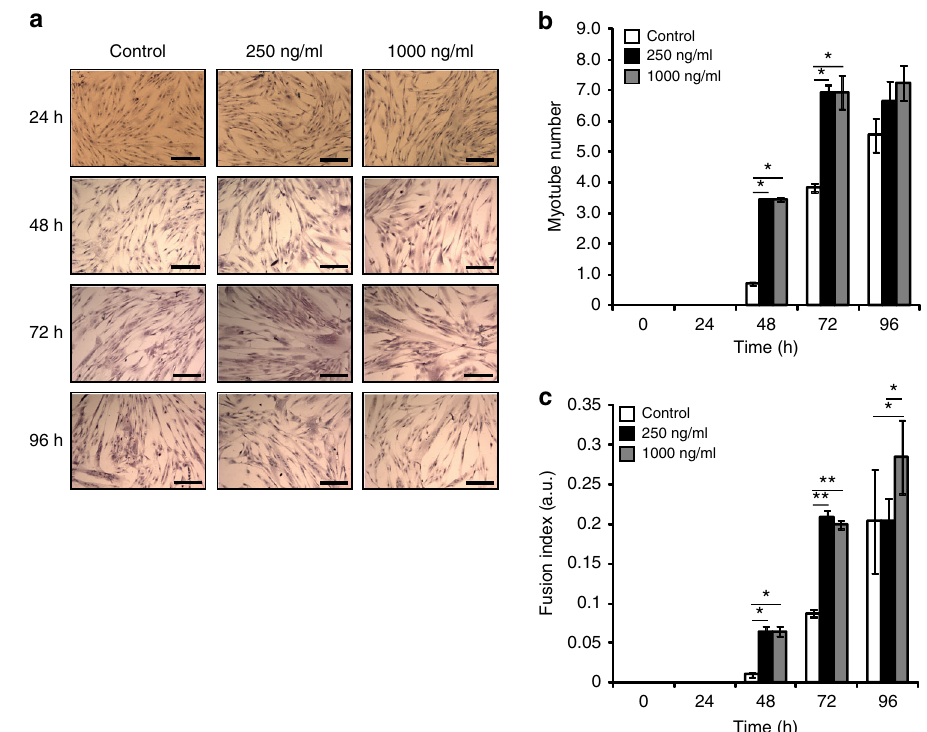
Fig. 3 Irisin enhances myogenesis in primary human myoblast cultures. a Representative images of H&E-stained 36C15Q primary myoblasts at 24, 48, 72, and 96 h of differentiation in the presence of DB (control) or irisin (250 and 1000 ng/ml). b Graph showing quanti fi cation of myotube number at 0, 24, 48, 72, and 96 h of differentiation in the presence of DB (control) or irisin (250 and 1000 ng/ml). c Graph showing quanti fi cation of fusion index at 0, 24, 48, 72, and 96 h of differentiation in the presence of DB (control) or irisin (250 and 1000 ng/ml) ( n = 2 biological replicates). Error bars represent mean ± SEM. One-way ANOVA was performed for all relevant fi gure panels. Signi fi cance is indicated with * p < 0.05 and ** p <